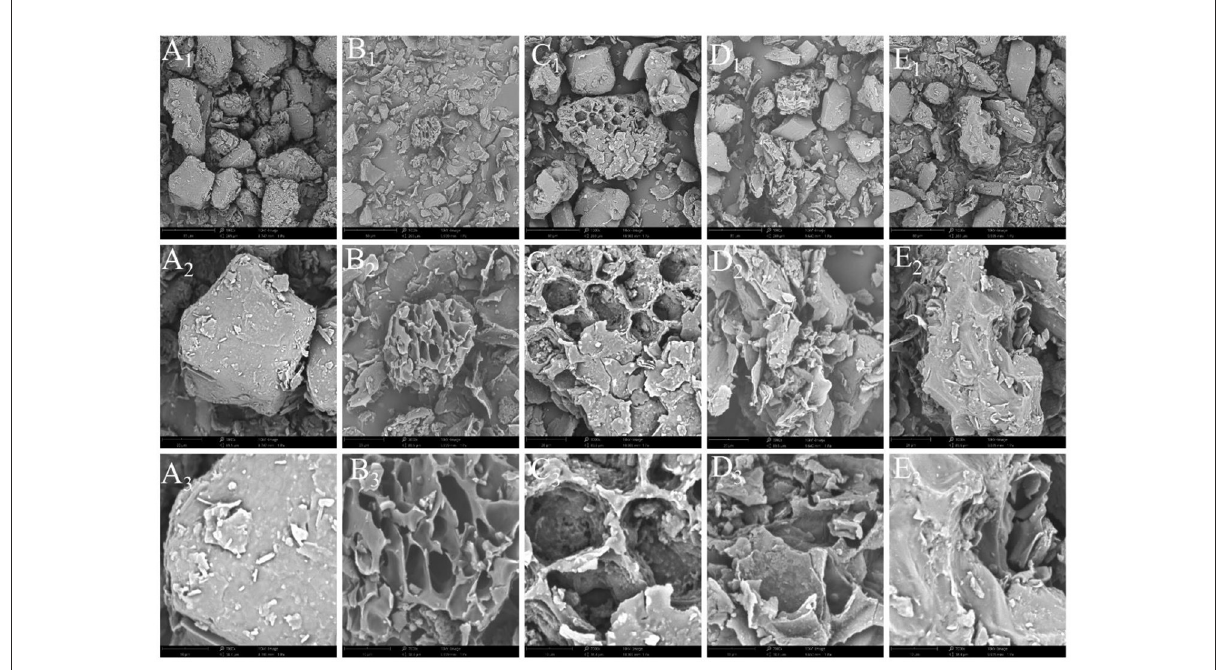
FIGURE2 Microstructure of pepper powder (A) and maceration (B) , UAE (C) , MAE (D) , and UMAE (E) after treatment. Subscripts 1, 2, and 3 represent magnifications of 1000x, 3000x, and 7000x, respectively.